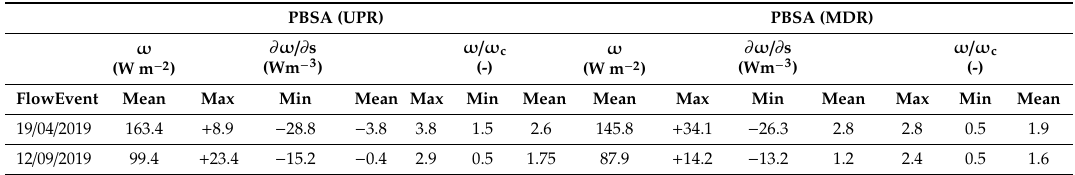
Table 3. Basic statistical data relative to stream power variables estimated for the events of 19 April 2019 and 12 September 2019 in the PBSA (UPR) and